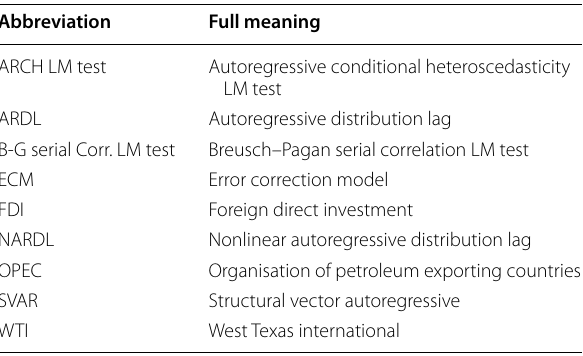
Table 6 Meaning of some acronyms. Source: Computed